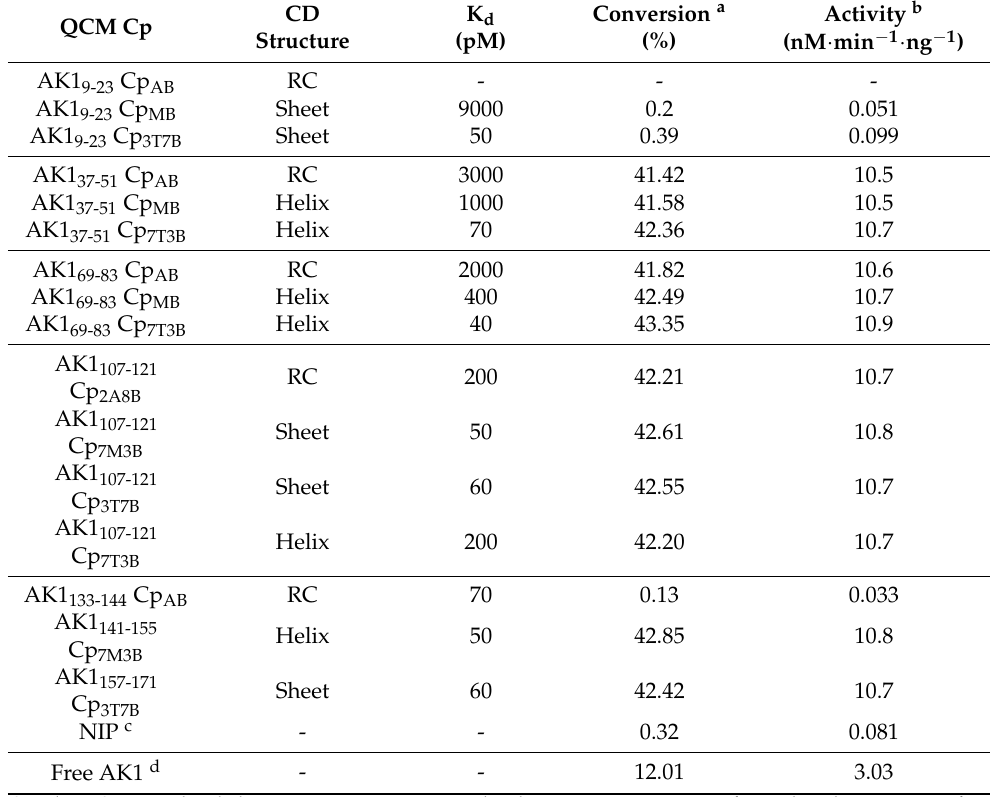
Cp, chip; CD, circular dichroism; NIP, non-imprinted polymer. Assays were performed in the presence of an AK1-integrated QCM Cp (~20 Hz) with 2 mL 20 mM PBS (Na 2 HPO 4 and NaCl), pH 7.4, containing 25 µ M AMP, 25 µ M ATP, and 5 µ M MgCl 2 at 37 ◦ C for 90 min. a Conversion (%) as a measure of AK1 activity was determined by the rates of AMP and ATP transphosphorylation. The data were obtained using HPLC. b The mean values of three consecutive measurements using the same chip. c Only one measurement was performed.